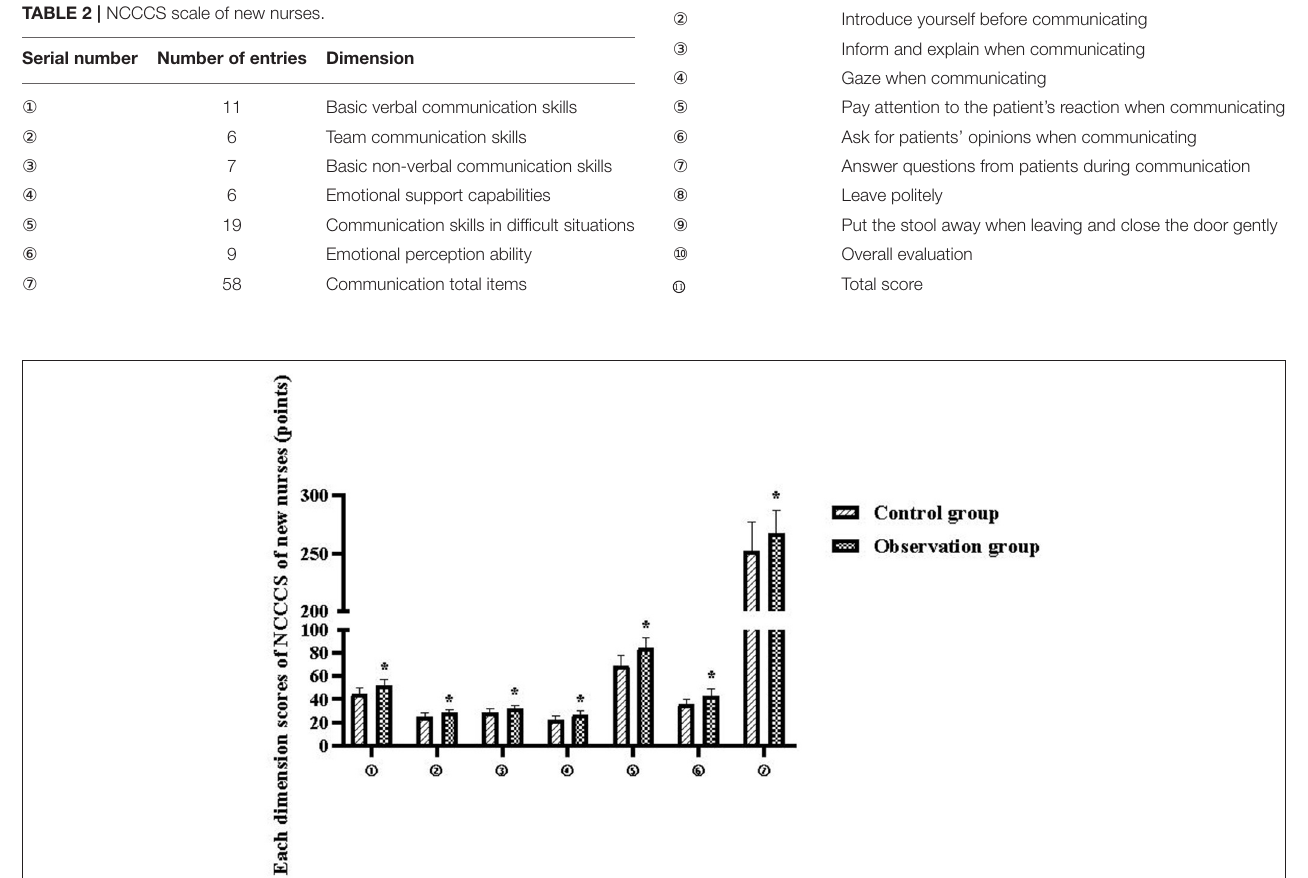
FIGURE 1 | Each dimension scores of NCCCS of new nurses. Compared with the control group, * P < 0.05.